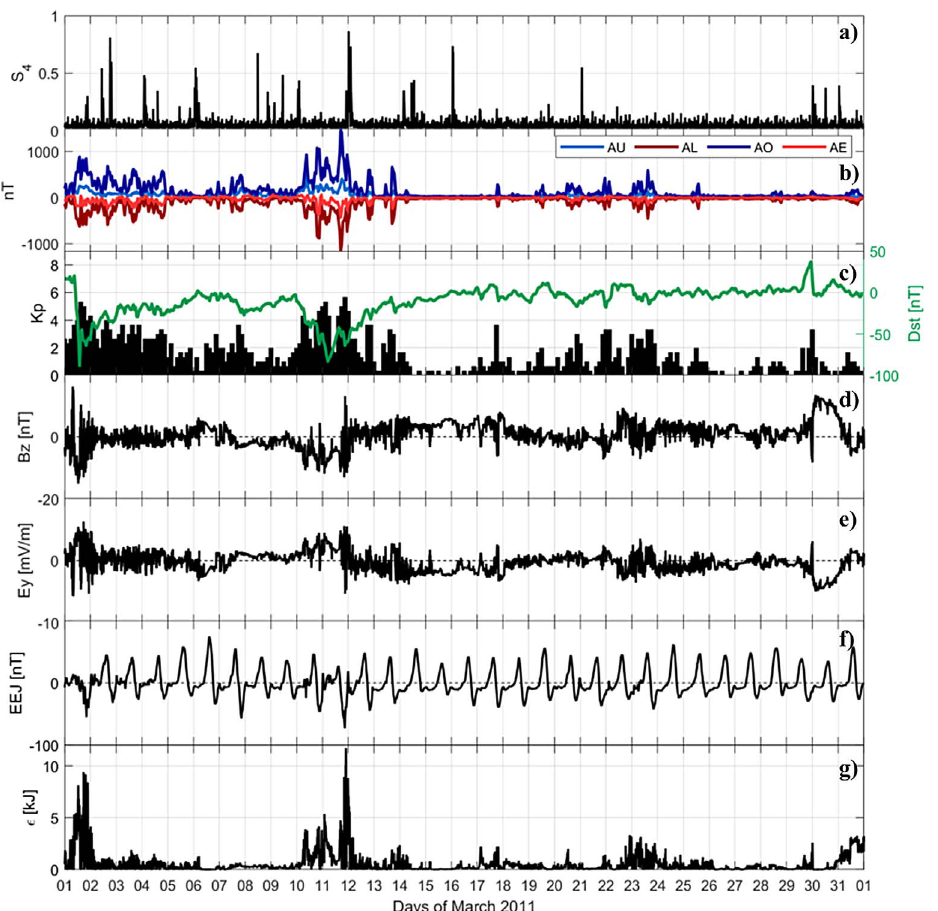
Fig. 2. Time pro fi les of (a) S 4 , (b) auroral activity indices, (c) Kp and Dst, (d) IMF-Bz, (e) IEF-Ey, (f) EEJ and (g) Akasofu ( e ) parameter for March